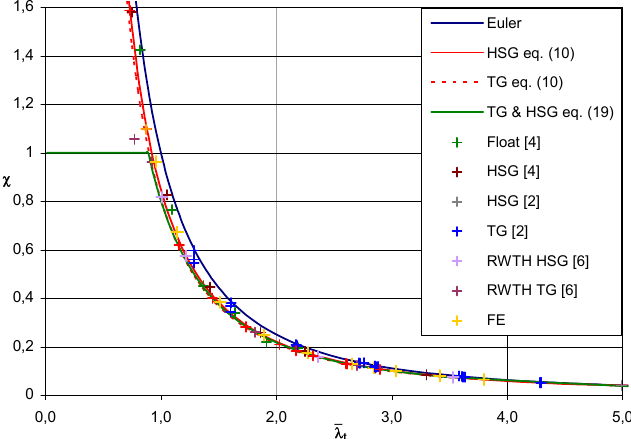
Figure 8: Comparison of the analytic buckling curves for monolithic glass columns to experimental test results without regular